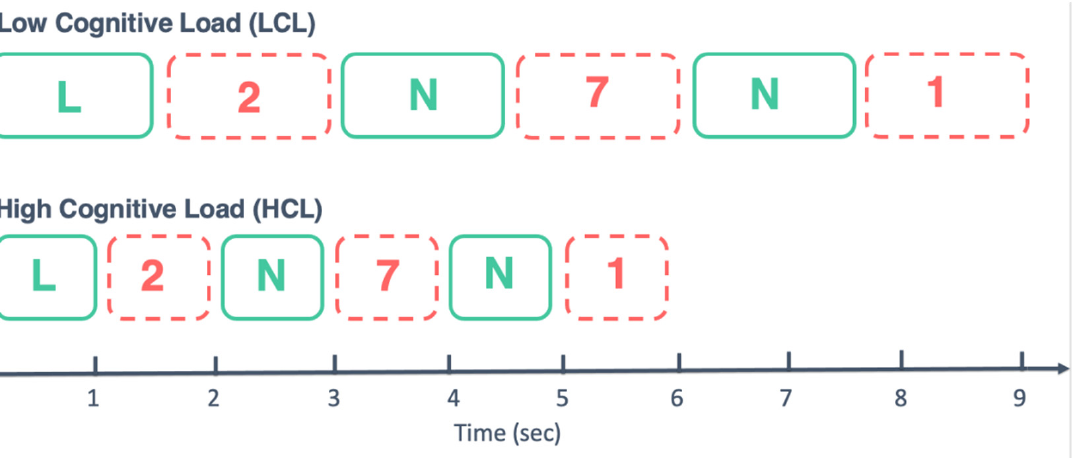
Figure 2. Course of the TloadDback task in both cognitive load conditions. ISI (interstimulus interval) in the LCL condition was determined as 1/3 longer than in the HCL condition (i.e., ISI (LCL) = ISI (HCL) + 1/2 ISI (HCL)).